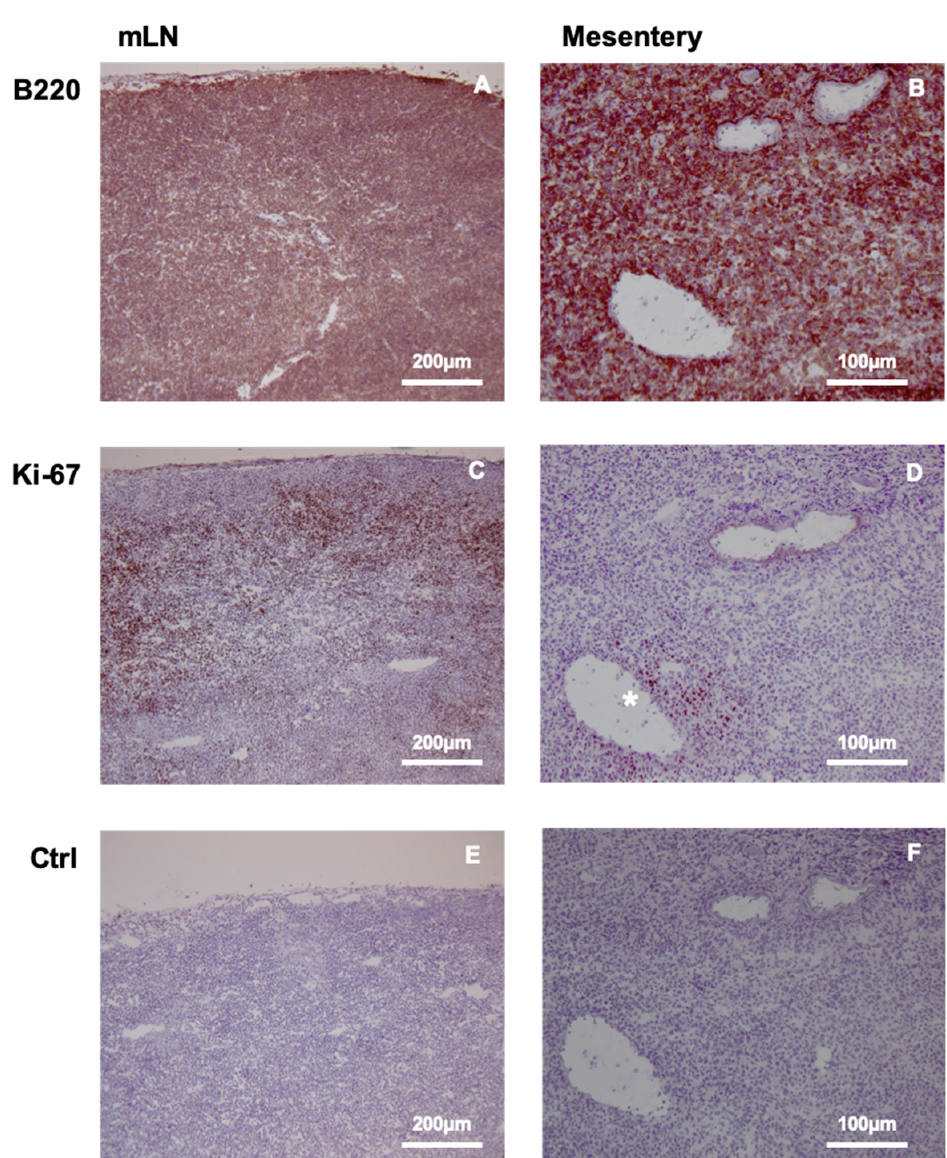
Figure 4. DLBCL accumulation and proliferation in mesenteric lymph node (mLN) and mesentery. B220 staining of mLN ( A ) demonstrates lymphoma expansion throughout the tissue, while the expression of proliferation marker Ki-67 ( C ) reveals preferential proliferation in the cortical region, and less prominent division is observed in the medullary area. The mesentery also contains diffusely distributed B220-positive DLBCL cells ( B ), with dividing cells positive for Ki-67 marker restricted to the area surrounding the mesenteric vein ( D ) (labeled with *). Negative control staining of mLN and the mesentery are shown in ( E , F ).